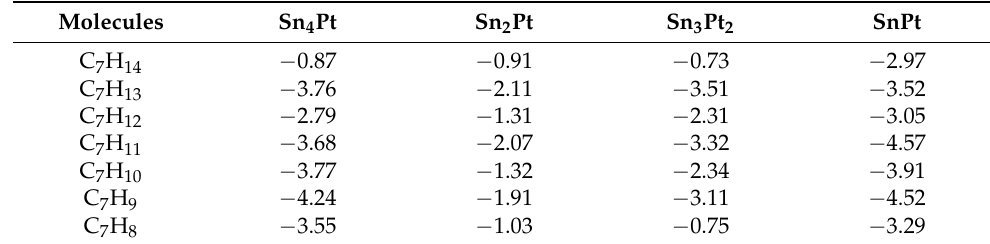
Table 1. Methylcyclohexane (C 7 H 14 ), the dehydrogenation intermediates and toluene (C 7 H 8 ), and the calculated adsorption energies (in eV) for Sn–Pt surfaces